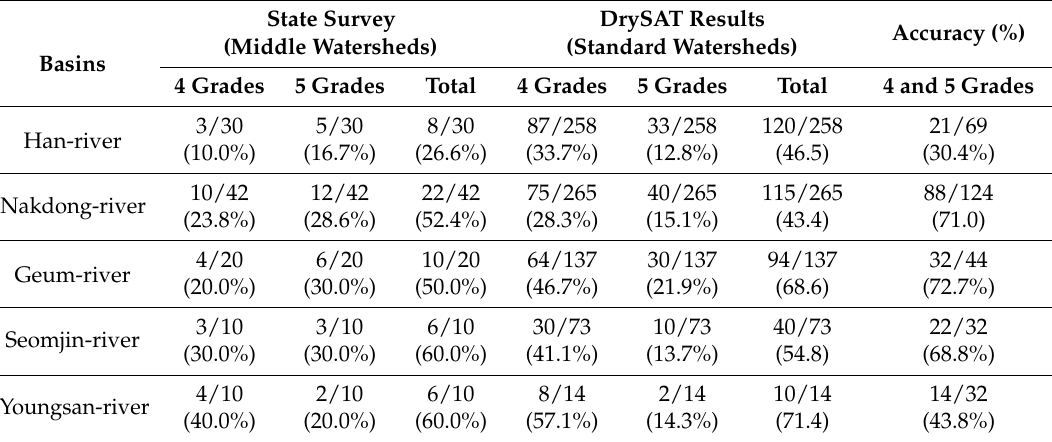
Table 3. Average classified SDI accuracy of 4 and 5 grades between the DrySAT and the status survey report results from 2001 to